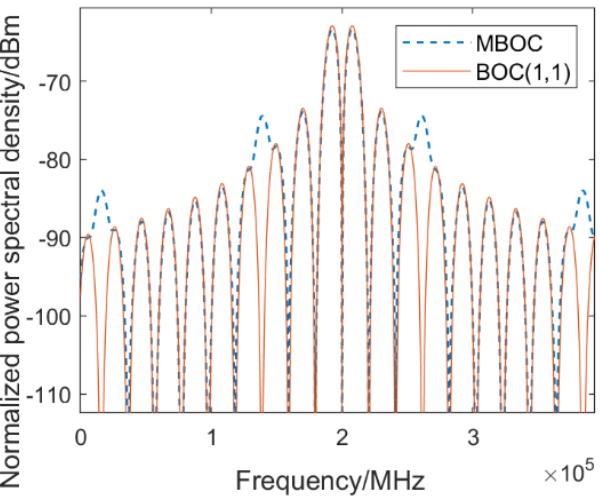
Figure 1. Normalized power spectral density of the MBOC (6,1,1/11) signal.